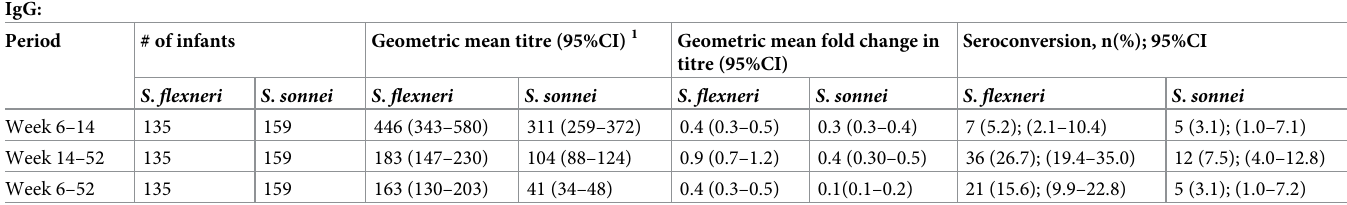
Table 3. Serum IgG anti- S . flexneri 2a or S . sonnei LPS response.